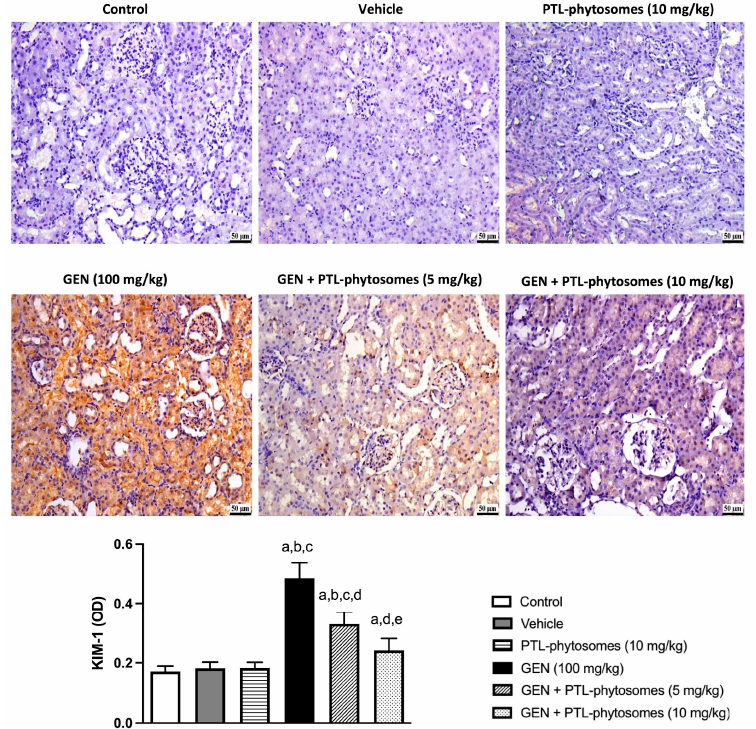
Figure 6. PTL-phytosomes prevented GEN-induced kidney injury by suppressing KIM-1 expres- sion. The immunohistochemical staining section was quantified as optical density (OD). Data are expressed as Mean ± SD ( n = 6). a: significant when compared to control at p < 0.05; b: significant when compared to vehicle at p < 0.05; c: significant when compared to PTL-phytosomes at p < 0.05; d: significant when compared to GEN alone at p < 0.05; e: significant when compared to GEN + PTL- phytosomes (5 mg/kg) at p < 0.05, scale bar 50 μ